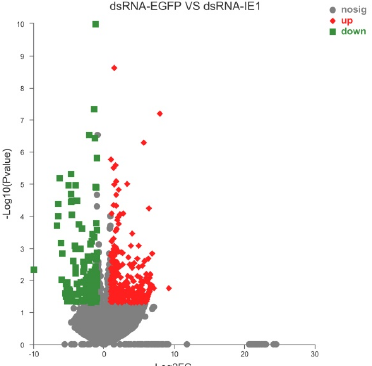
Figure 2. Volcano diagram of the DEGs in WSSV − infected shrimp after IE1 knockdown. The x − axis indicates the fold change of unigenes/transcripts between dsRNA − IE1 and dsRNA − EGFP group, and the y − axis shows the statistical significance of the differences ( p value). Red dots represent the DEGs that are significantly upregulated, whereas green dots represent the DEGs that are signifi- cantly downregulated. The gray dots represent the DEGs that have no significant difference.